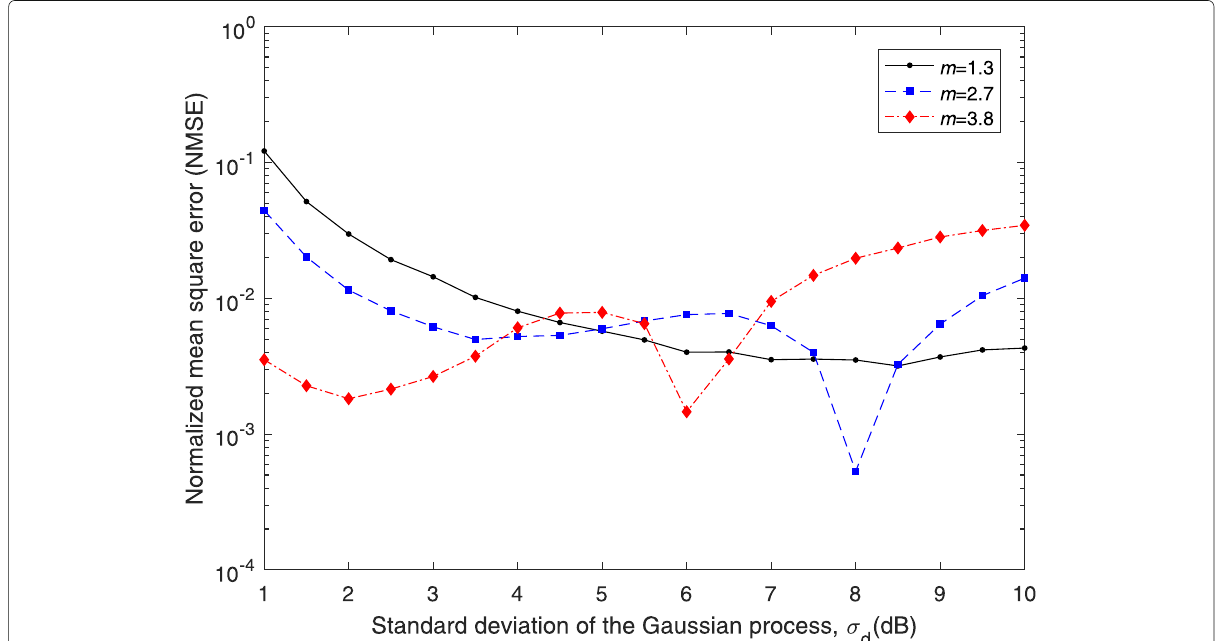
Fig. 6 Normalized mean square error of the ˆ σ d estimator as a function of the standard deviation of the Gaussian process for N = 10,000 samples and fading parameters of the Nakagami- m process, m = 1.3, 2.7 and